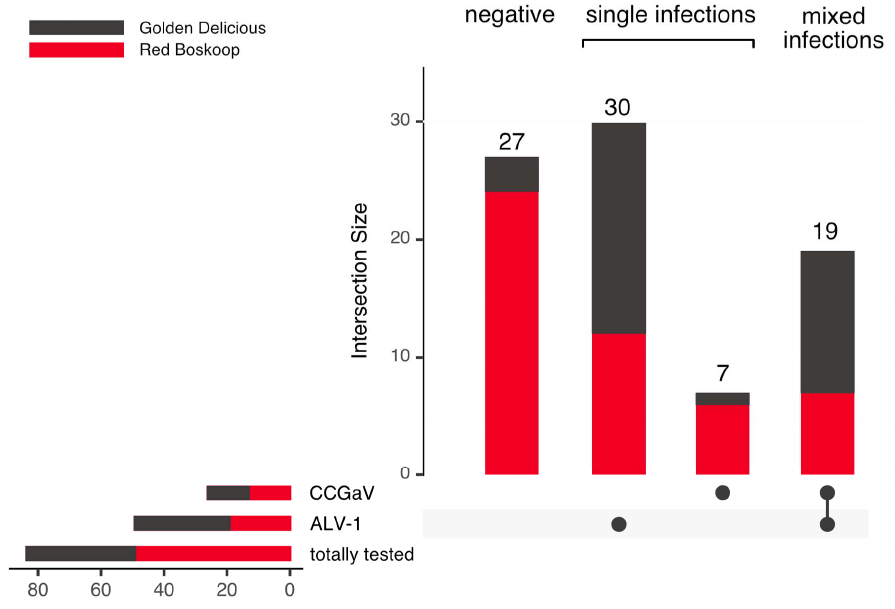
Figure 9. UpSet plot of infections in Red Boskoop (RB) and Golden Delicious (GD) scions grafted on M9 rootstocks. Horizontal bars show the total number of virus-positive cases. Vertical bars display the number of negative, single, and mixed infections.